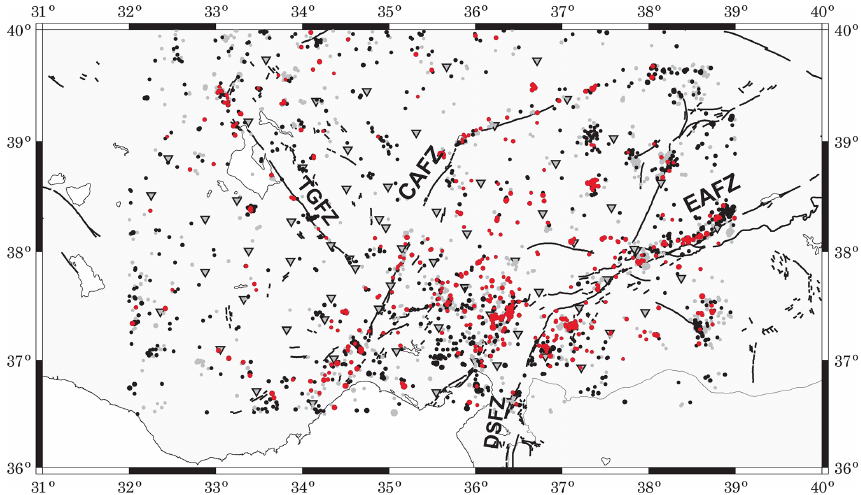
Figure 2. Epicentral distribution of all local events selected from the study area in the KOERI catalog. Gray circles represent earthquakes with poor quality that are not considered for the current study, while black indicates the location of local events with good quality. Red circles among these events are 487 events used in coda wave inversion since they are successful at passing the quality criteria for a further preprocessing